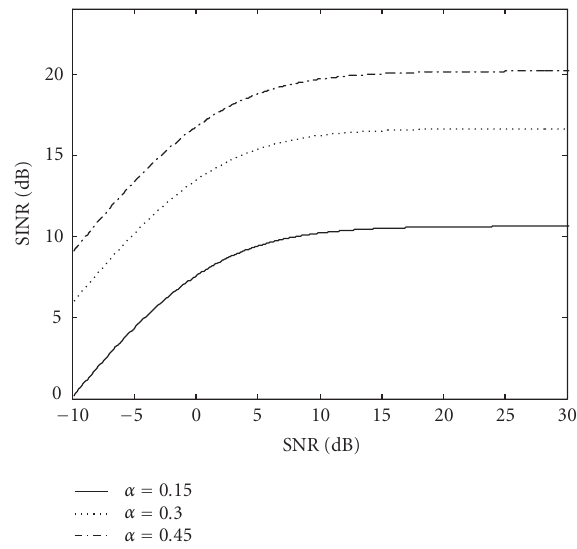
Figure 5: Symbol error rate of the overlay OFDM system with QPSK modulations.